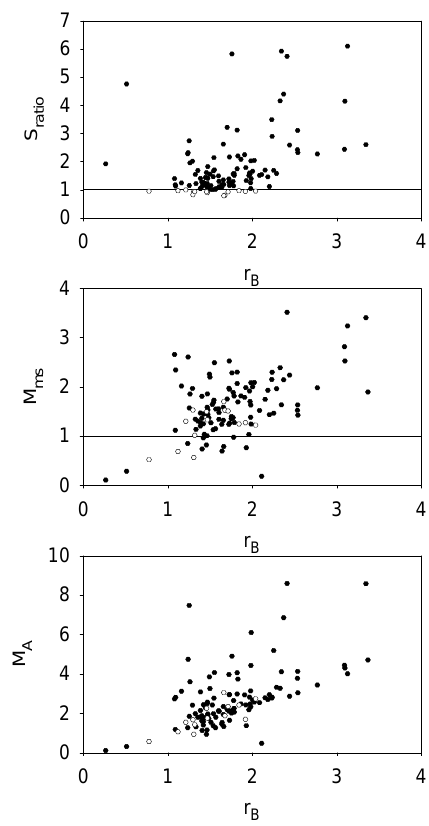
Fig. 6. These results are obtained using 2-plasma point up and downstream data periods, using only proton data and γ = 1 . 5. Top panel shows the entropy ratio against r B , middle panel the magnetosonic Mach number against r B , and bottom panel the Alfv´en Mach number against r B . Filled circles have entropy increases and open circles have entropy decreases.